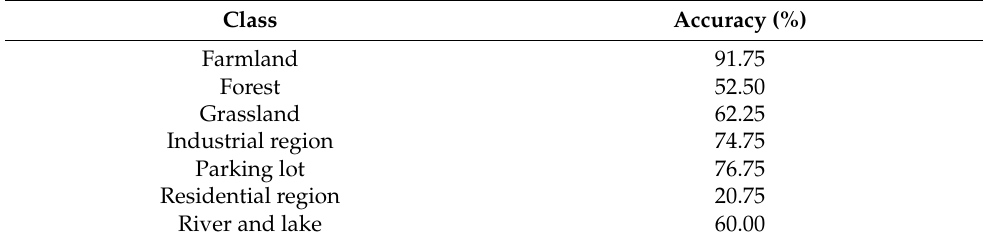
Table 6. Accuracy of various scenes in the cross-domain scene classification of the NWPU-RESIST45 and RSSCN7 datasets of the